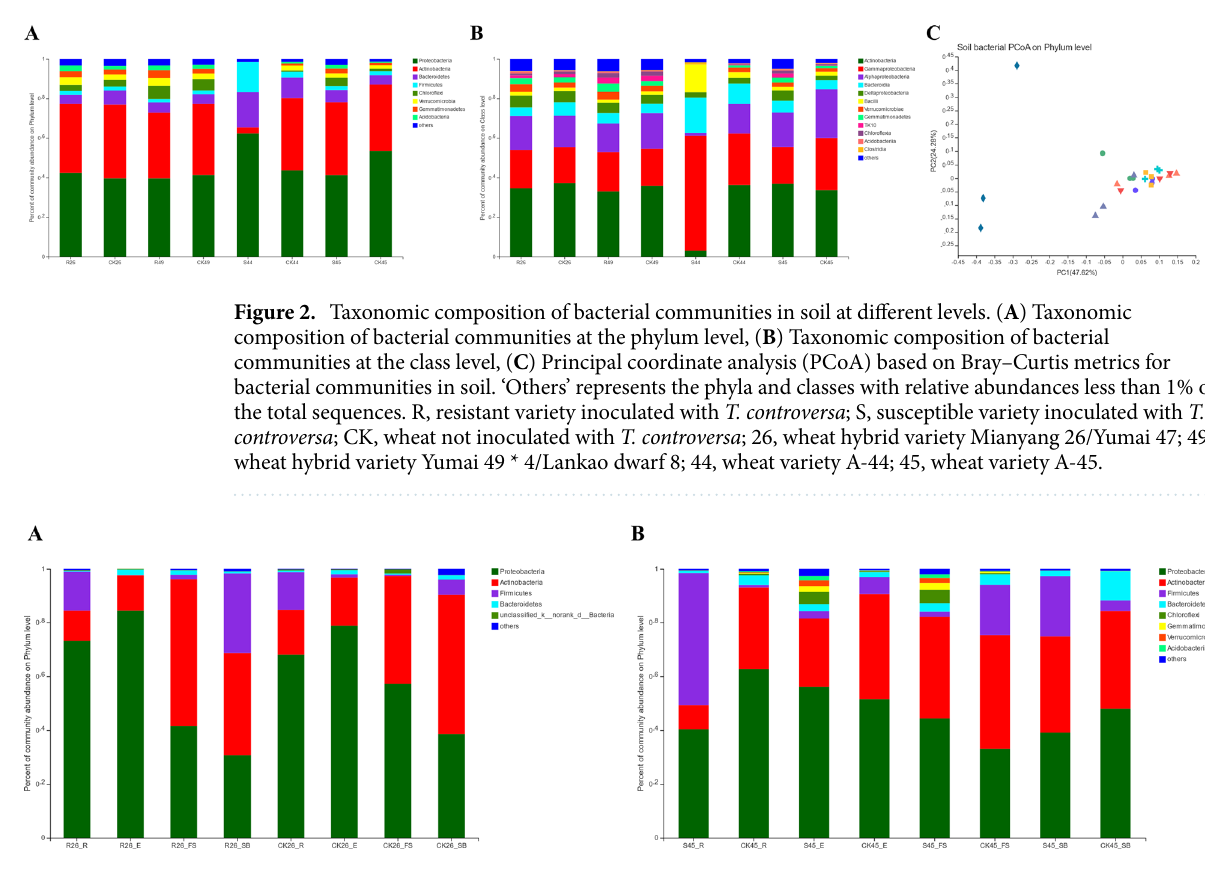
Figure 3. Taxonomic composition of the endogenous bacteria in the roots (R), stem base (SB), first stem under the ear (FS) and ear (E) of two wheat varieties. ( A ) The taxonomic composition of the disease-resistant variety Mianyang 26/Yumai 47 at the phylum level; ( B ) The taxonomic composition of the susceptible variety A-45 at the phylum level. ‘Others’ represents the phyla and classes with relative abundances less than 1% of the total sequences. R, resistant variety inoculated with T. controversa ; S, susceptible variety inoculated with T. controversa ; CK, wheat not inoculated with T. controversa ; 26, wheat hybrid variety Mianyang 26/Yumai 47; 45, wheat variety